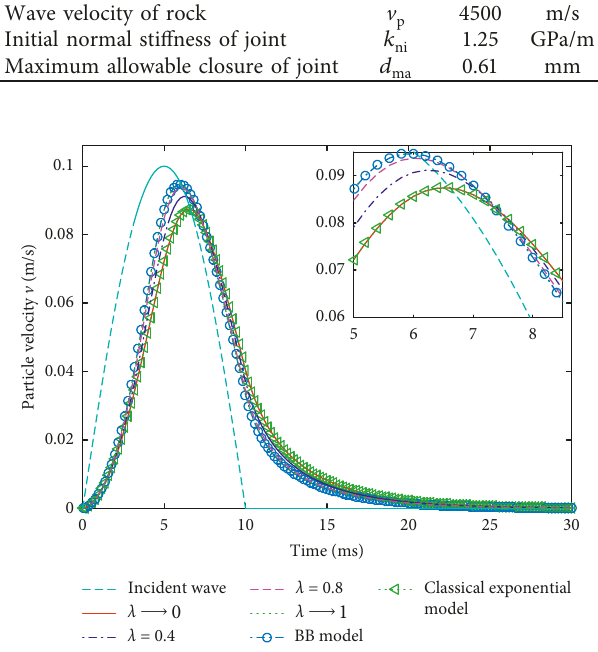
Figure 5: Effect of amplitude on the energy transmission co- efficient with different λ